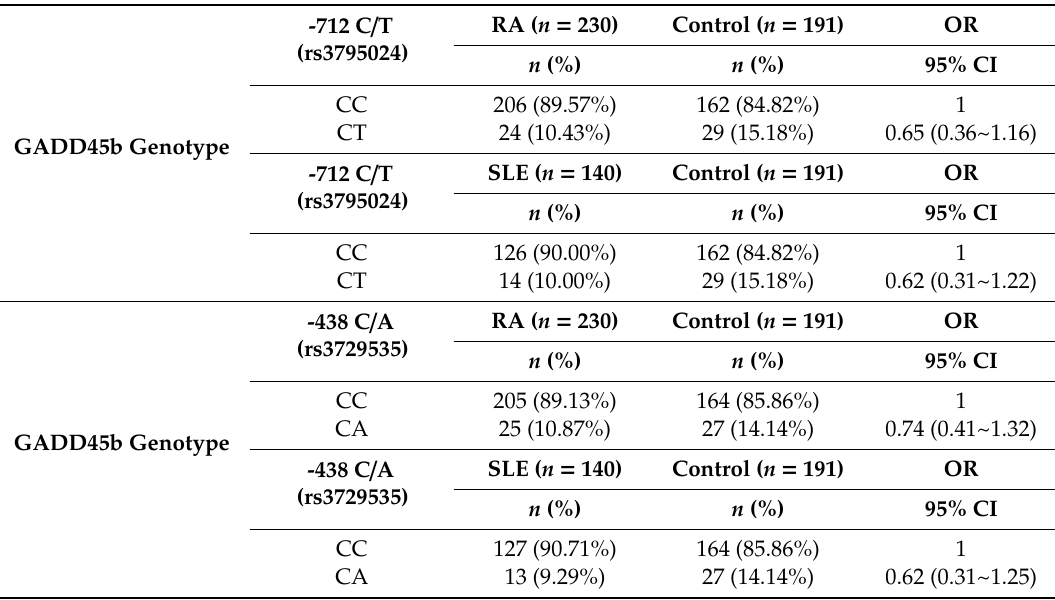
Table 3. Genotypes frequency of -712C / T, -438C / A GADD45b gene in RA and SLE patients.